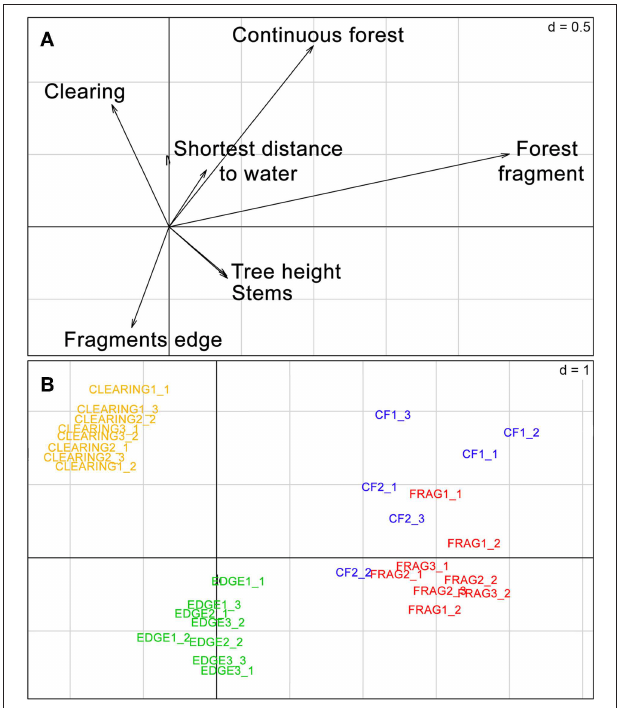
FIGURE 2 | Biplots from the Hill-Smith PCA of the environmental gradients (R table). (A) Environmental variables. (B) Sites. C, clearing; FF, forest fragment; CF, continuous forest; E, edge.